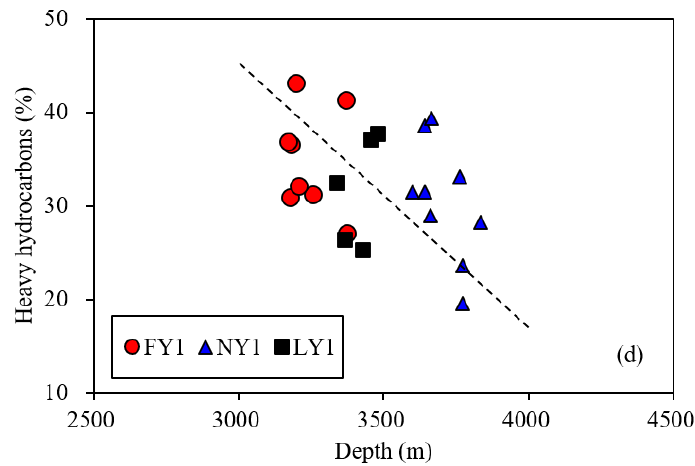
Figure 8. Plots showing relationships of burial depths with EOM contents ( a ), EOM/TOC ( b ), and light ( c ) and heavy ( d ) hydrocarbons for the studied samples.